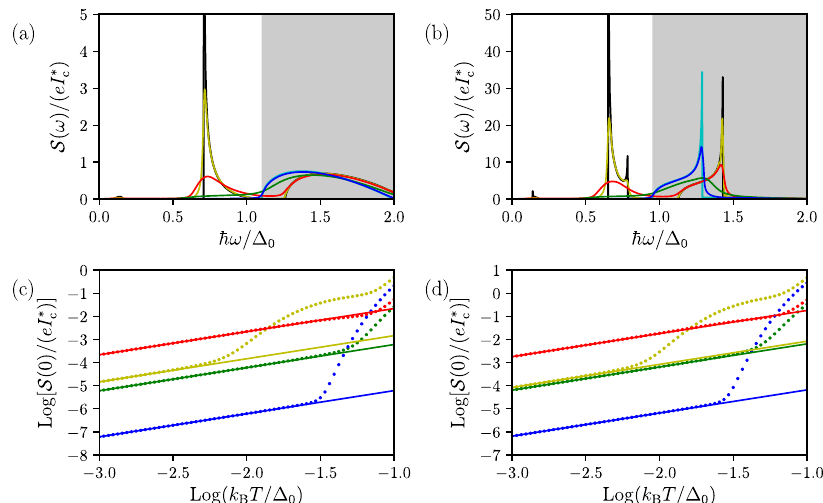
at ϕ = ϕ * , as a function of frequency ω , and the Fermi energy is set at Fig. 5 Supercurrent power spectrum. Panels ( a ) and ( b ) show S ð ω Þ , in units of eI (cid:4) c = 0 and μ = 5 ħ v L , respectively. In both panels a and b, one has T = 10 − 2 Δ k n t 2 = Δ 2 μ ¼ 0 : 1, γ = 0 + (black lines) γ = 10 − 2 Δ 0 (yellow lines), 0 0 D / 0 / B , imp 0 0 γ = 10 − 1 Δ γ = Δ γ = 10 Δ γ = ∞ (cyan lines). The shaded region is the frequency domain where the 0 (red lines), 0 (green lines), 0 (blue lines), and supercurrent power spectrum is non-zero in a clean GJJ. Panels c and d show the static supercurrent power spectrum S ð 0 Þ , in units of eI (cid:4) function of temperature, in a log-log scale, and the Fermi energy is set at μ 0 = 0 and μ 0 = 5 ħ v D / L , respectively. In both panels c and d, one has γ = 10 − 2 Δ 0 (yellow circles), γ = 10 − 1 Δ 0 (red circles), γ = Δ 0 (green circles), γ = 10 Δ 0 (blue circles), each colored solid line represents the corresponding low- temperature linear behavior by Eq. (30). The temperature dependence of the order parameter Δ 0 is neglected, and the impurity density is set at n t 2 = Δ 2 ¼ 0 : imp 0 0